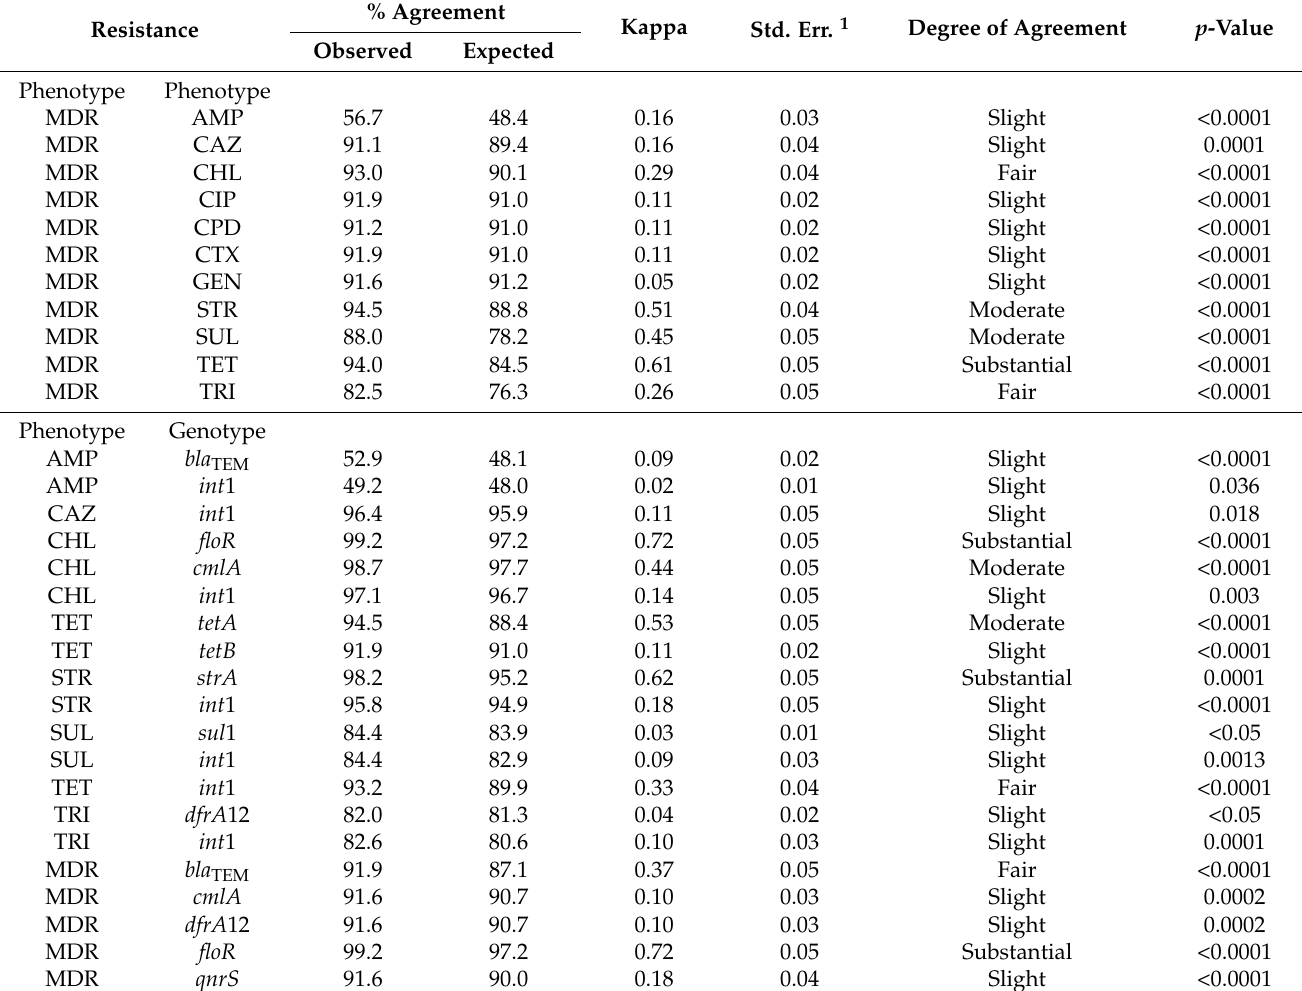
Table 4. Kappa analysis among phenotype, genotype, and resistance determinants ( n = 384).